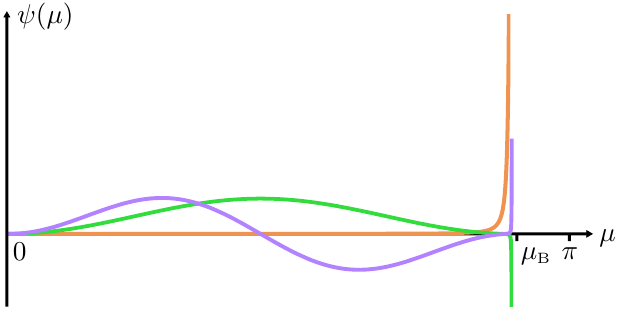
Figure 4 . This (cid:12)gure illustrates the spatial pro(cid:12)le of the (cid:12)rst few normalized graviton modes in the presence of a large tension brane, and a Z 2 orbifolding across the brane. We use the spatial coordinate (cid:22) , related to (cid:26) in eq. (2.3) by cot (cid:22) = sinh (cid:26)=L . The tension is adjusted such that the . (cid:25) . As discussed in the main text, the presence of the location of the brane is at (cid:22) = (cid:22) with (cid:22) B B brane creates new bulk modes (orange), which are highly localized at the brane, and which play the role of a (nearly massless) graviton on the brane. The remaining bulk modes appear as KK modes in the brane